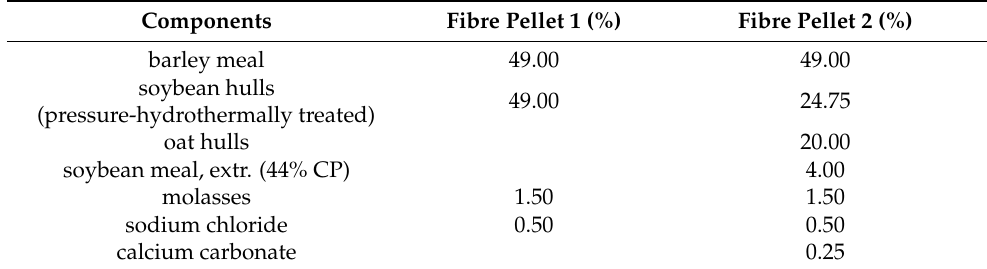
Table 2. Composition of fibre pellet 1 and fibre pellet 2 according to the declaration.